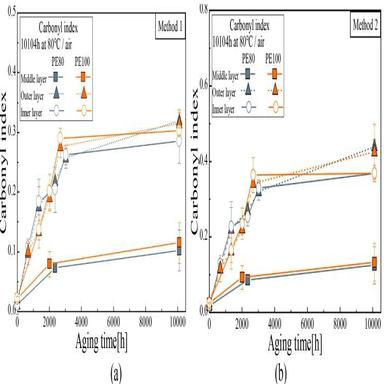
Carbonyl index change with the position of PE80 and PE100 by using method 1 (a) and method 2 (b).